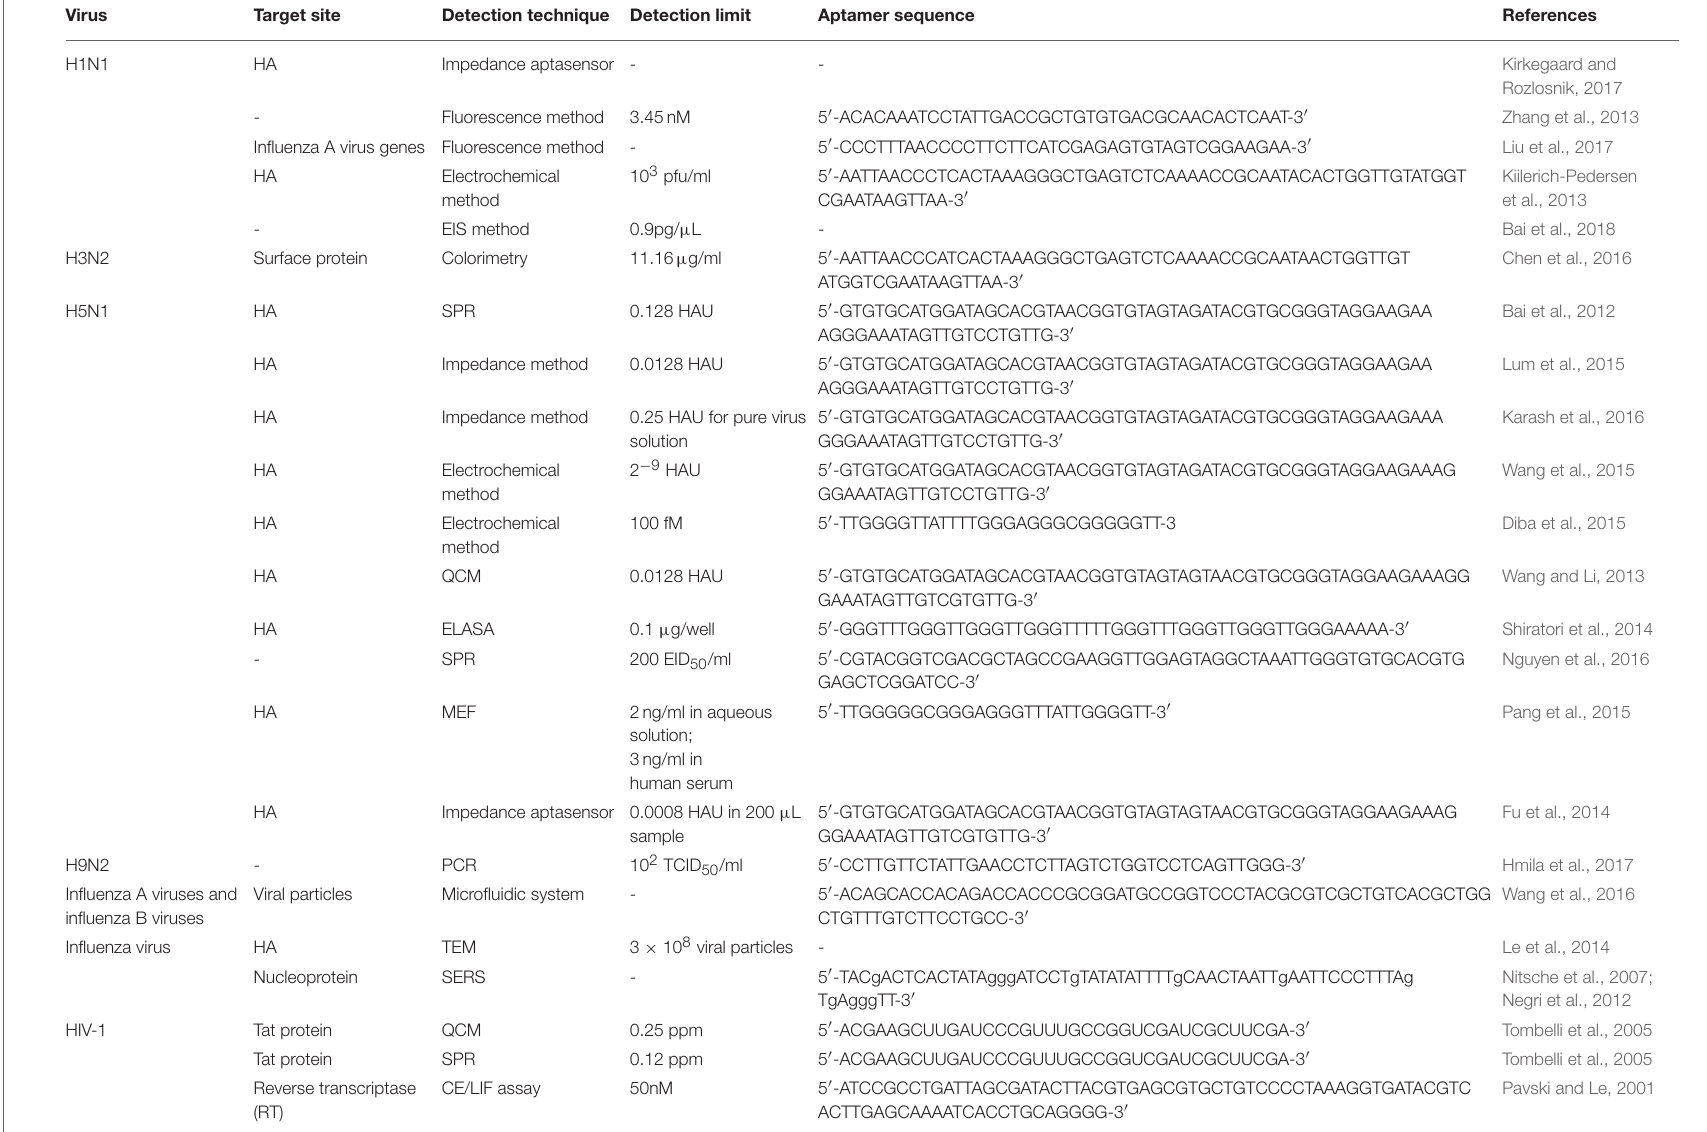
TABLE 2 | Summary of aptasensors applied in virus